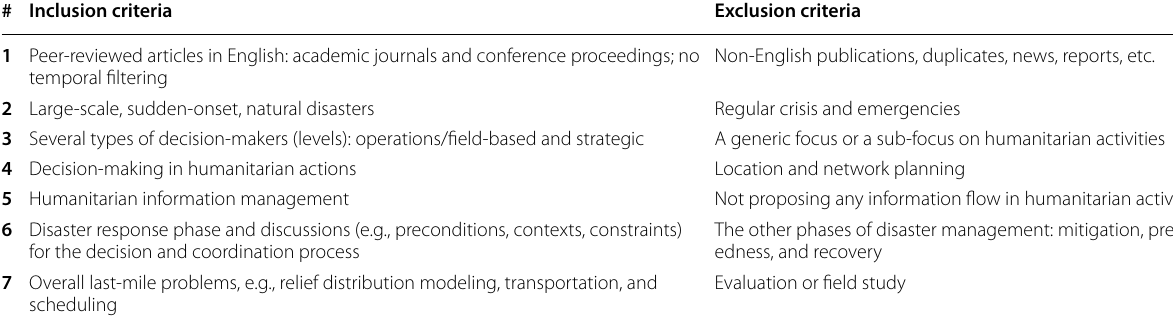
Table 2 Articles inclusion and exclusion criteria in the first round of